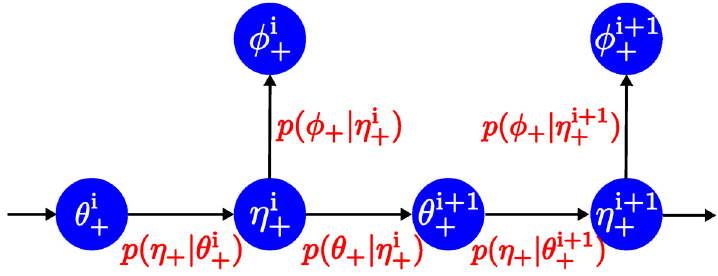
Fig 3. Flowchart showing how the torsional angles are determined probabilistically in a “ forward ” way, i.e., from the 5 ’ -end to the 3 ’